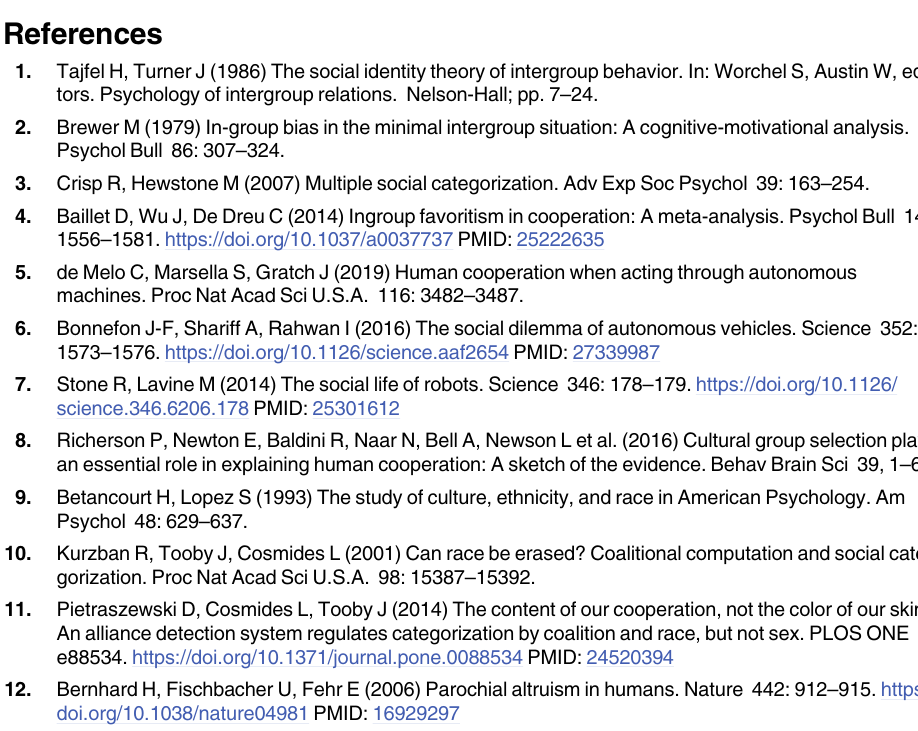
S1 Table. Descriptive statistics for main